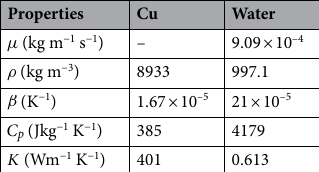
Table 2. Effective properties of nanoparticles and base fluid 75 .